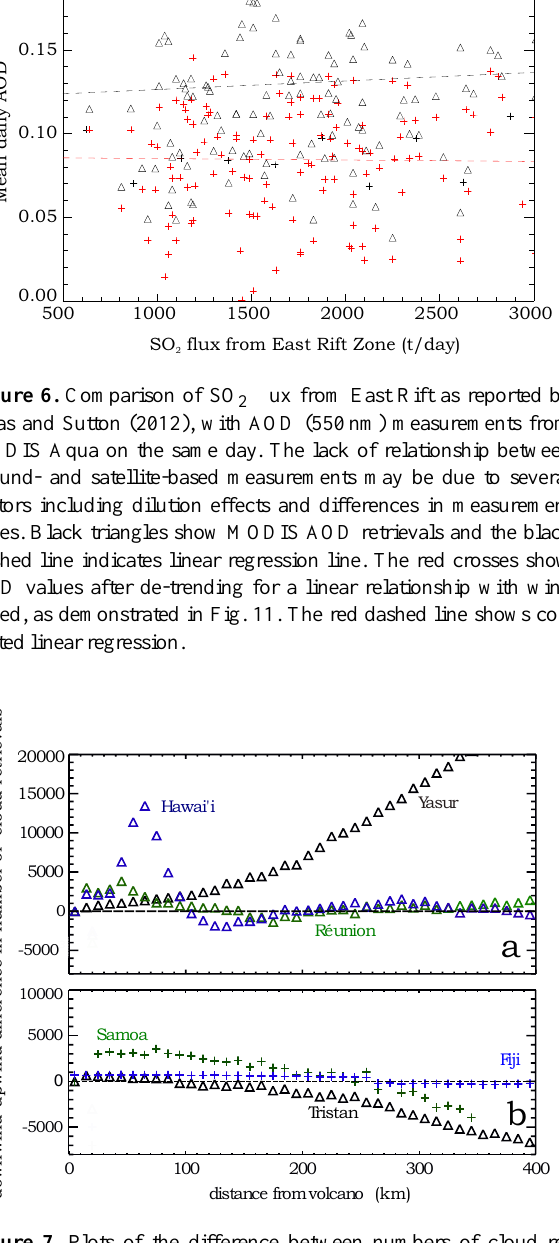
Figure 7. Plots of the difference between numbers of cloud re- Fig. 7. Plots of the difference between numbers of cloud retrievals trievals (cloud fraction >0.2) downwind and upwind of volcanic (cloud fraction > 0 . 2 ) downwind and upwind of volcanic vents vents (a) and island summits (b) from MODIS (Aqua), 2002–2008. (a) and island summits (b) from MODIS (Aqua), 2002–2008. At At Hawai’i,and to some extent Réunion, there is a notable increase Hawai’i, and to some extent R´eunion, there is a notable increase in in the number of cloud retrievals made downwind relative to upwind the number of cloud retrievals made downwind relative to upwind within 100km of the within 100 km of the island. Fig. 7. Plots of the difference between numbers of cloud retrievals (cloud fraction > 0 . 2 ) downwind and upwind of volcanic vents (a) and island summits (b) from MODIS (Aqua), 2002–2008. At Hawai’i, and to some extent R´eunion, there is a notable increase in the number of cloud retrievals made downwind relative to upwind within 100 km of the island.